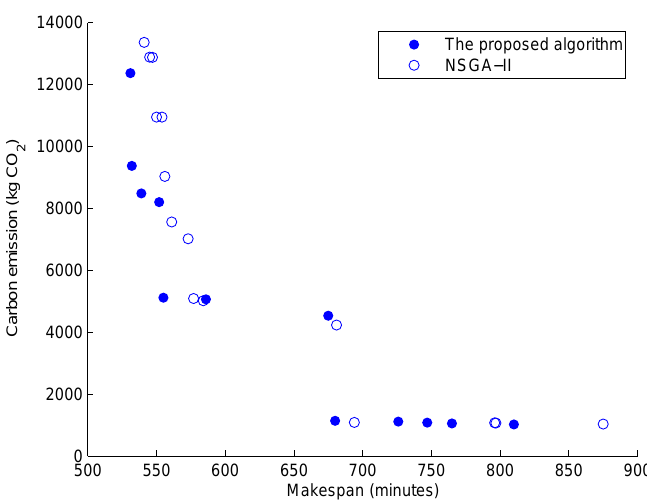
Figure 6. The Pareto front of the two